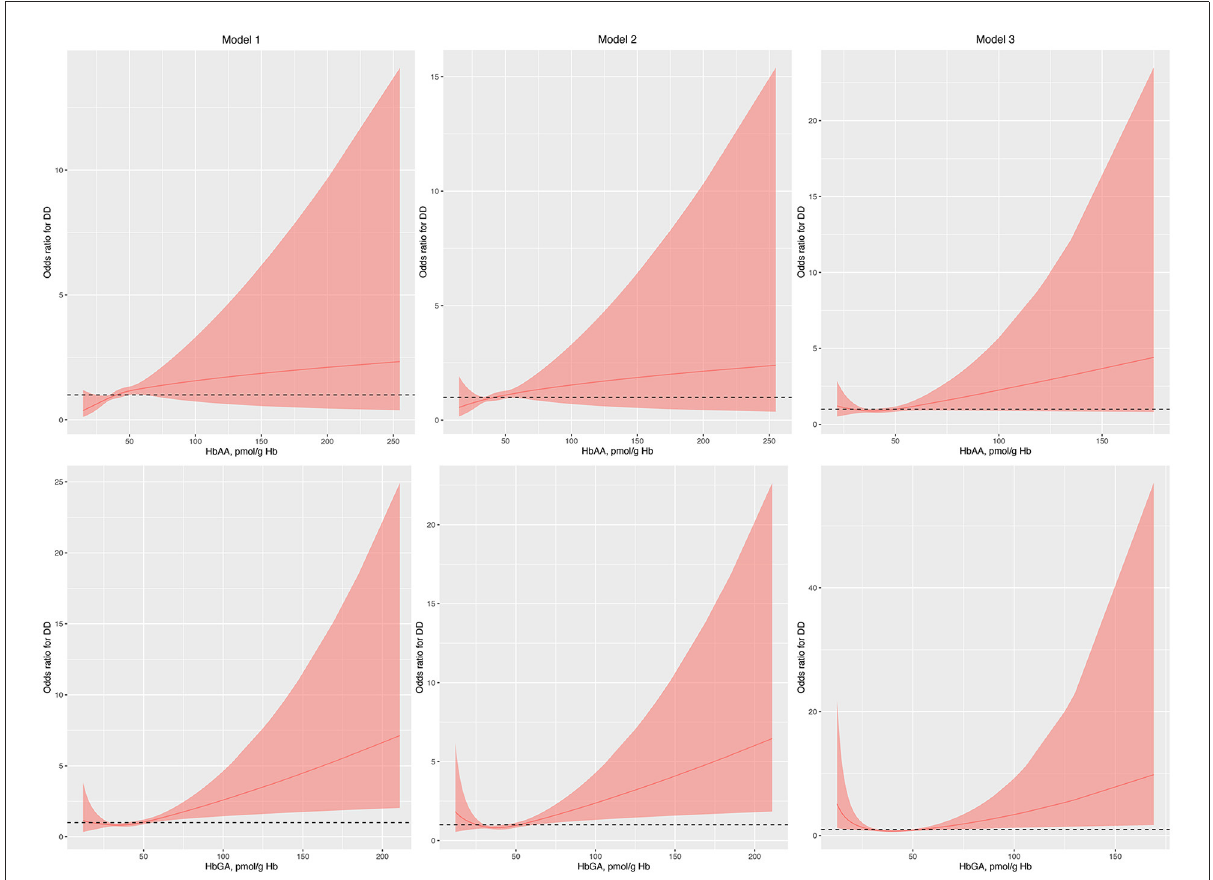
FIGURE1 Odds ratio (95% confidence interval) of developmental disabilities by blood HbAA and HbGA levels. Odds ratio (solid lines) and 95% confidence interval (curved lines) were based on binomial regression analysis with restricted cubic splines for log-transformed HbAA and HbGA levels. No covariables were adjusted for in model 1. Age, gender, race, and income were adjusted in model 2. Age, gender, race, income, BMI, normal birth weight, maternal smoking during pregnancy, health insurance coverage, and the number of annual health care visits were adjusted in model 3. BMI, body mass index; DDs, developmental disabilities; Hb, hemoglobin; HbAA, hemoglobin adducts of acrylamide; HbGA, hemoglobin adducts of